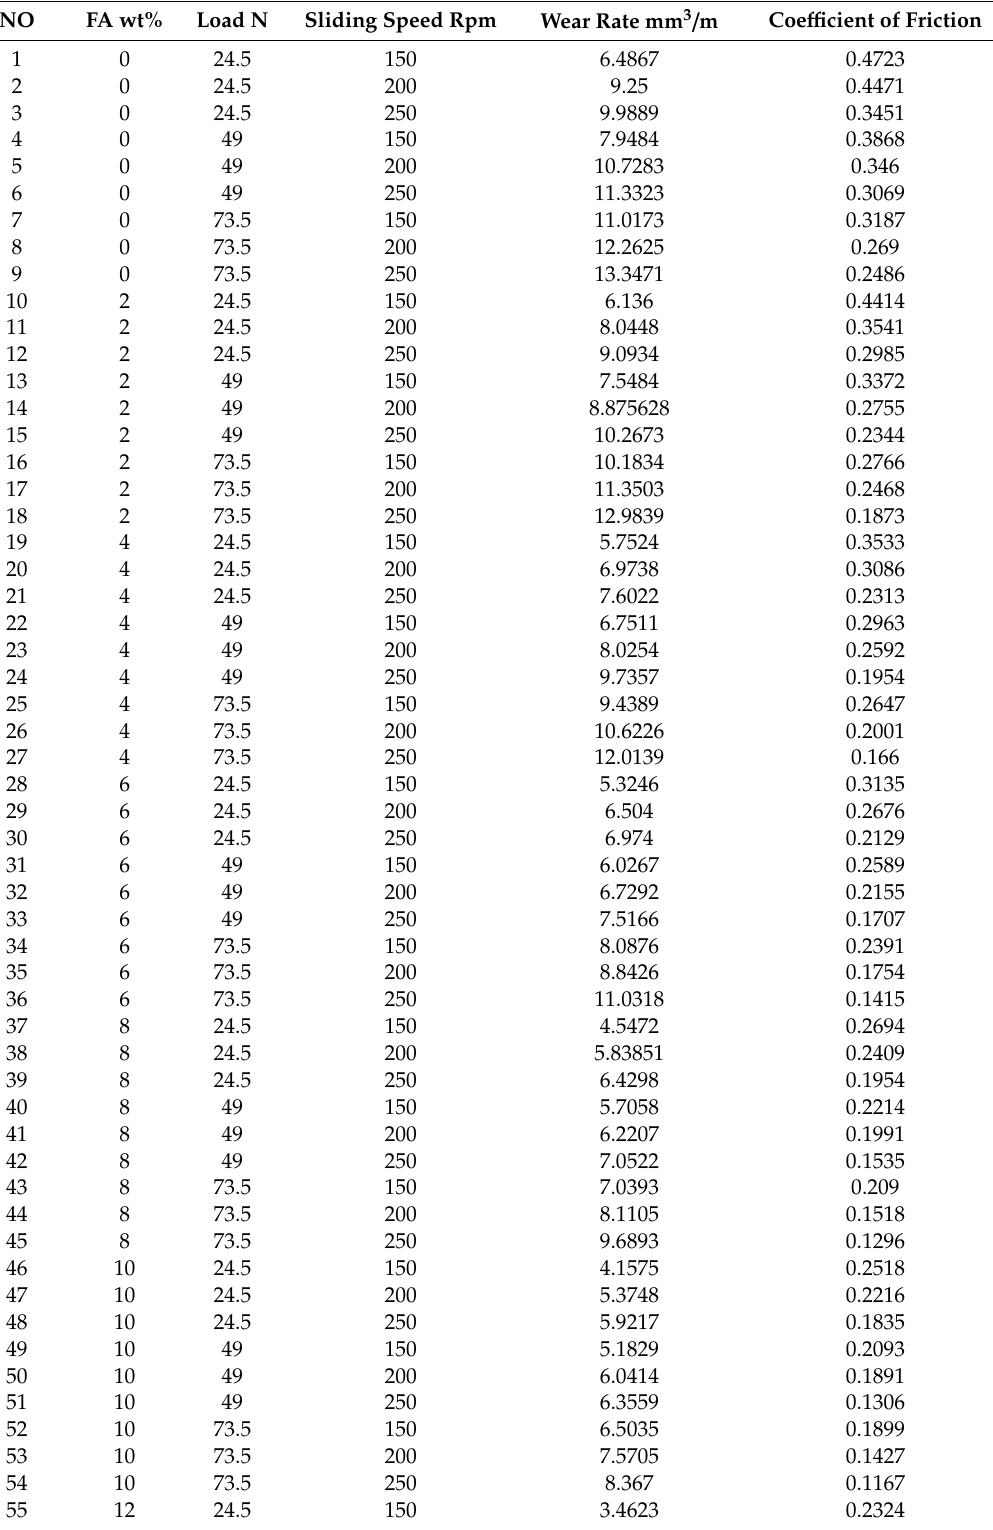
Table A1. Parameters used in mathematical models for wear